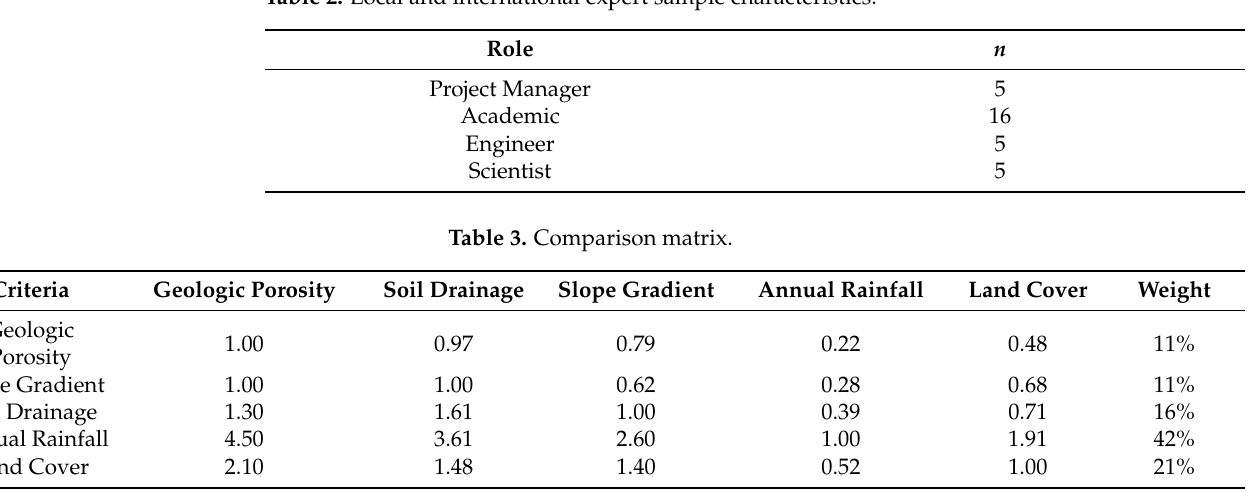
Table 2. Local and international expert sample characteristics.